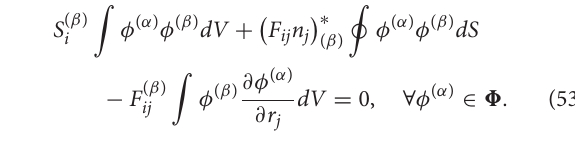
∂(cid:127) . Define the finite element